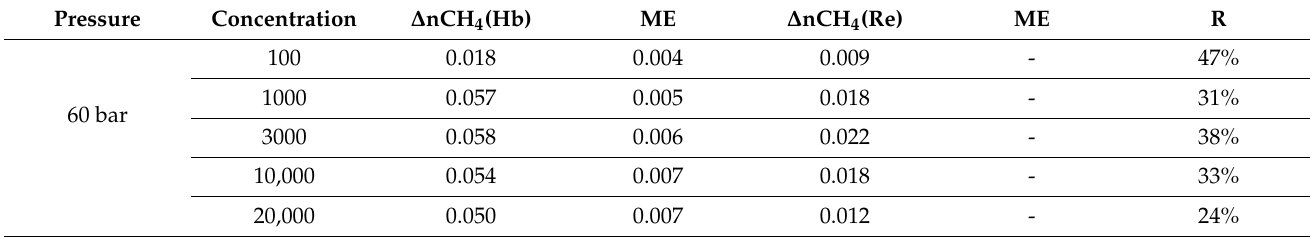
Table A10. Total mole CH 4 released (average from two experiments) in the presence of methionine at T = − 2 ◦ C. ∆ nCH 4 (Hb average) is the moles of CH 4 stored in hydrate at T = − 2 ◦ C. ∆ nCH 4 (R) (average) is moles of CH 4 release. Thus, R (average) is the ratio of mole released/mole stored in hydrate in 24 h. SD is standard deviation. * reported value for single